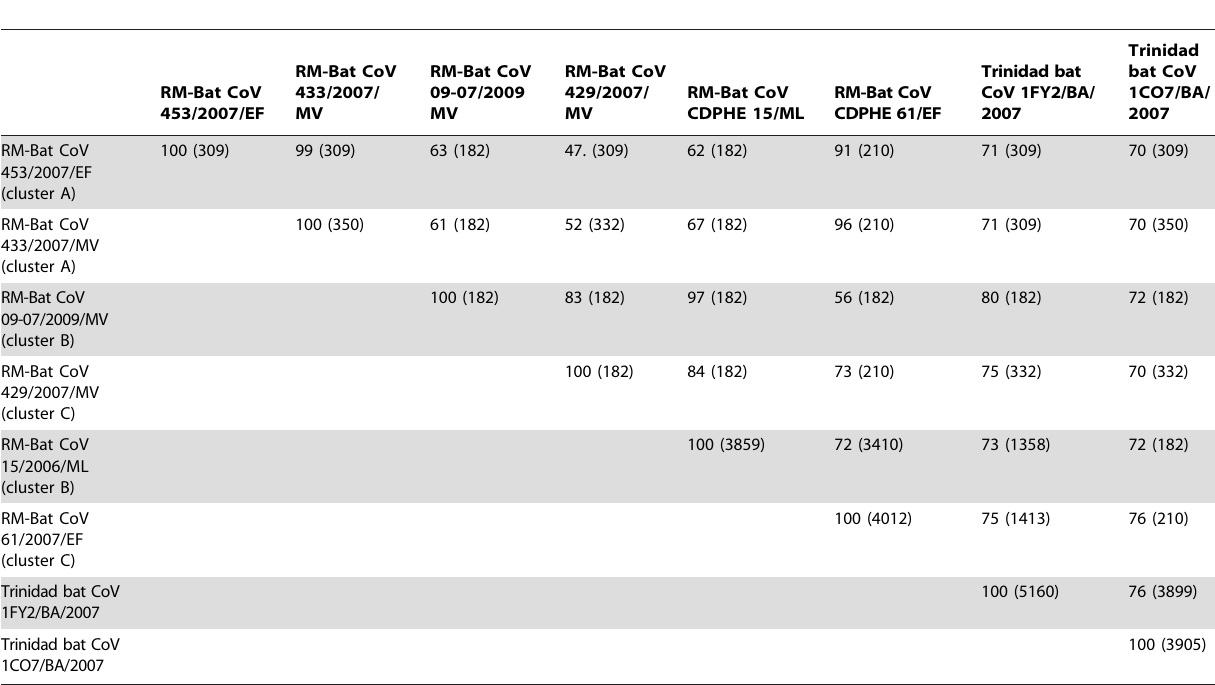
Table 5. Nucleotide Sequence Comparison of New World Bat Coronavirus RNA in the RdRp region.